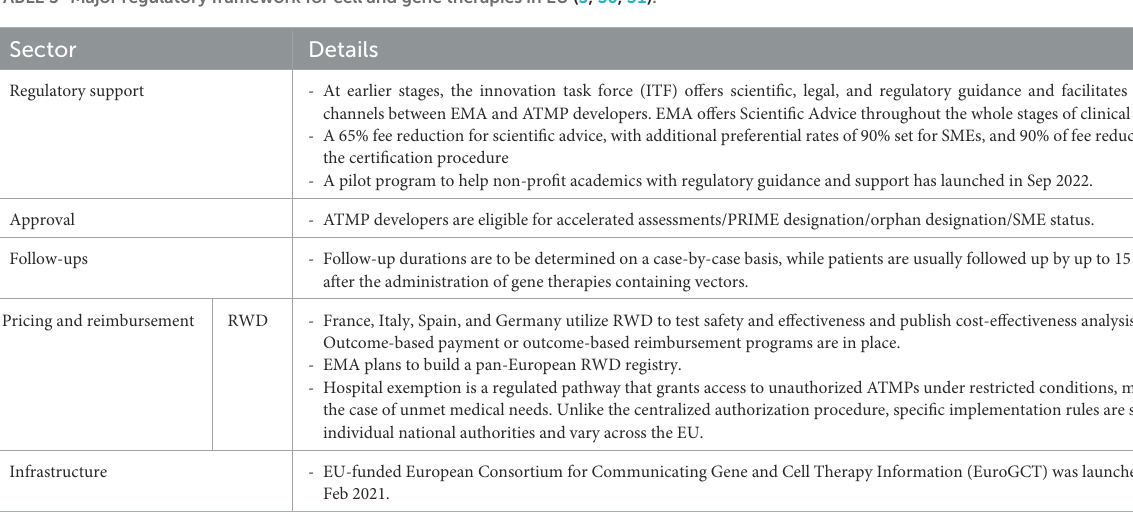
TABLE 3 Major regulatory framework for cell and gene therapies in EU (5, 30, 31).